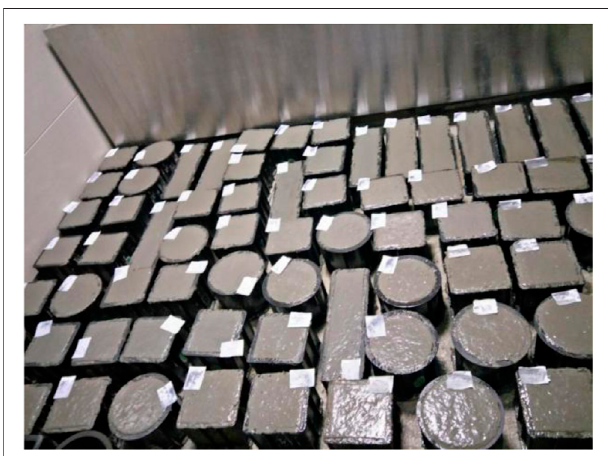
FIGURE 1 | Test block for the strength test.